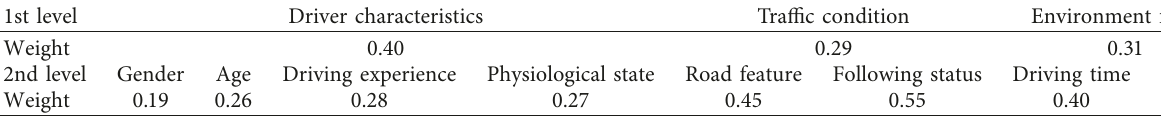
Table 2: Weight values of influencing factors.